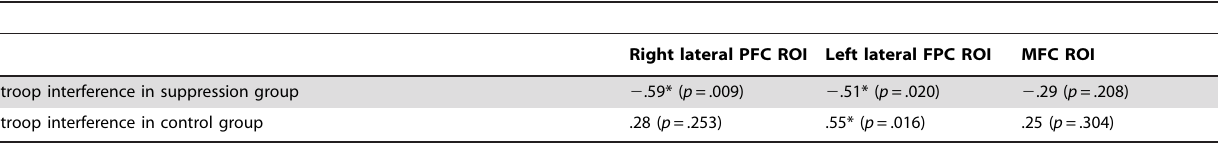
Table 3. Bivariate correlations between Stroop interference effects and mean brain activity in the three regions of interest (ROI) during the Stroop